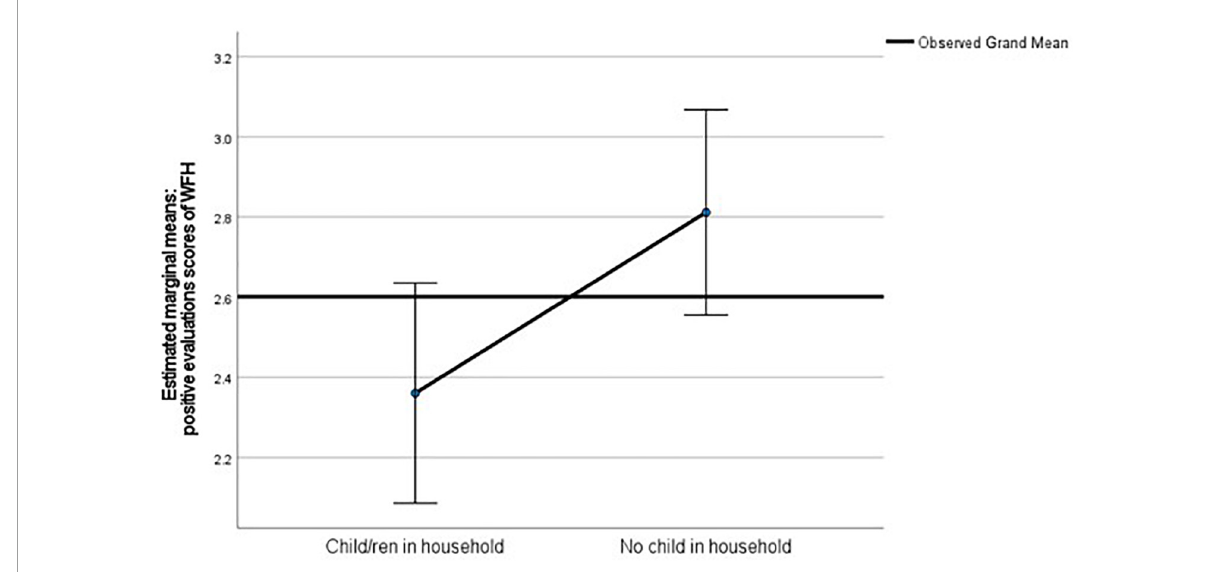
FIGURE1 Line chart of estimated marginal means of number of positive evaluations to WFH (min. = 0 - max. = 5) per household (HH) condition. Covariates appearing in the model are evaluated at the following values: Age = 41.08, Leadership position = 0.23. Current contractual working hours per week = 39.13, Female = 0.46; error bars: 95%